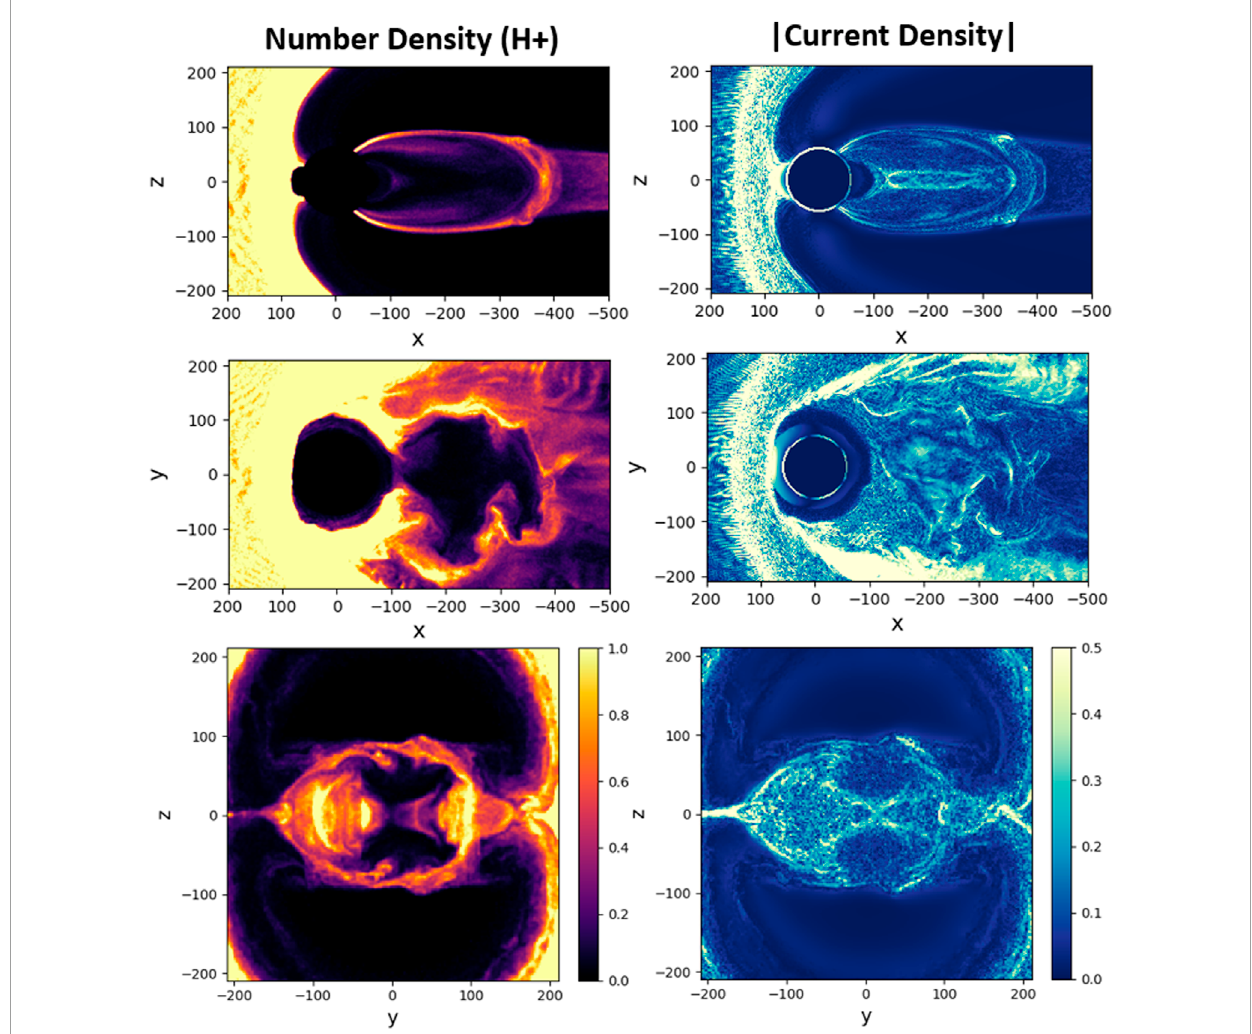
FIGURE 7 H+ number and absolute value of net current density, | J | in three cross-sections in the auroral outflow simulation at Ω cp t = 461: x–z ( y = 1 d i ) , x–y ( z = 1 d i ) , and y–z ( x = − 119 d i )